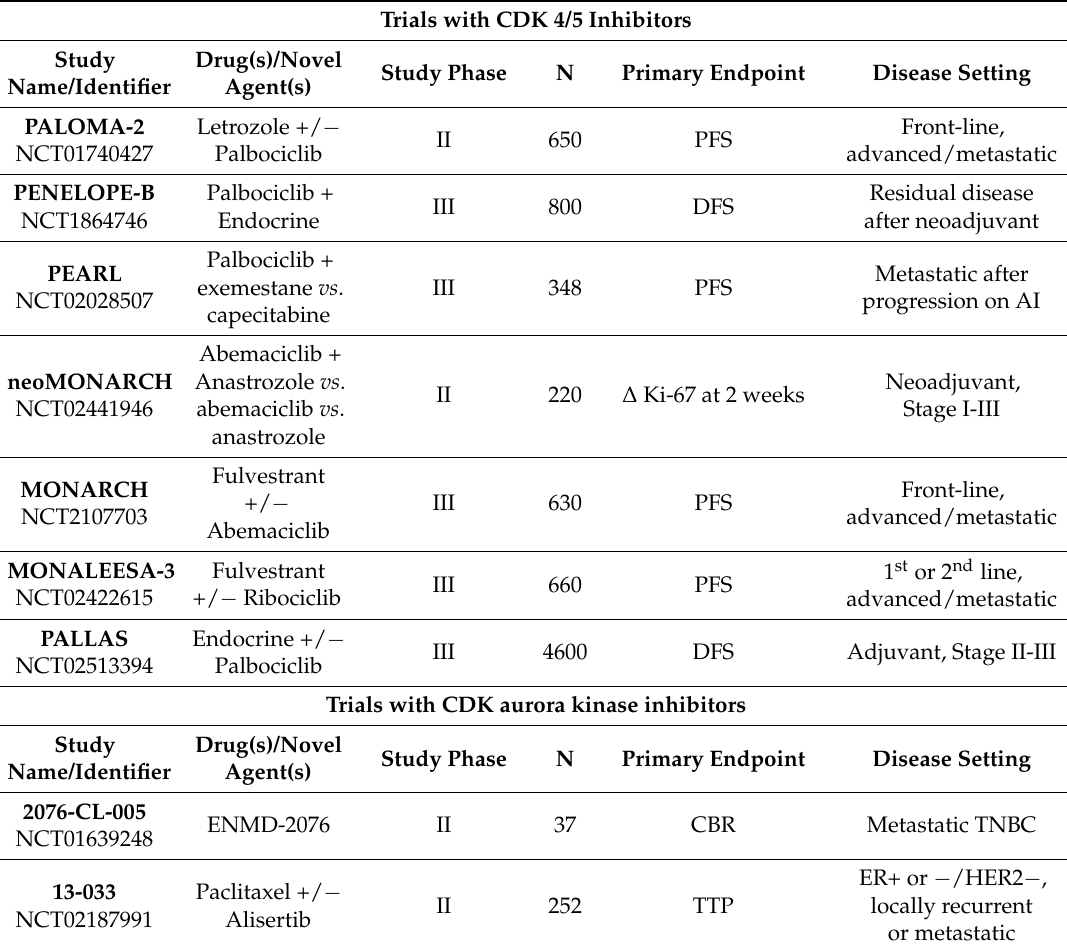
Table 1. Clinical Trials with cell cycle inhibitors in breast cancer